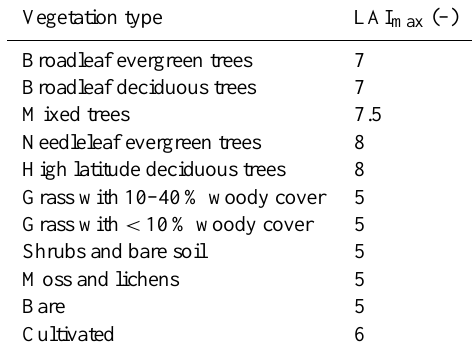
Table 2. LAI max values for different vegetation types (Sellers et al.,